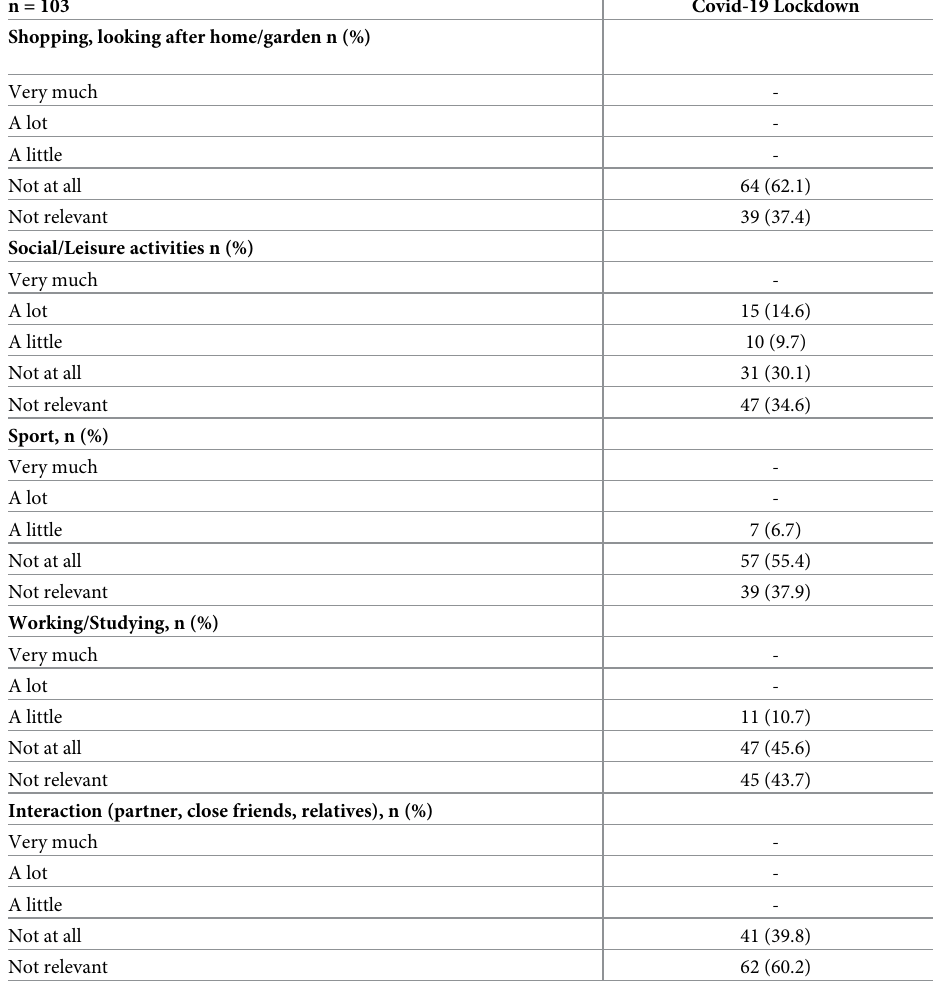
Table 2. Dermatology Life Quality Index measurement of social